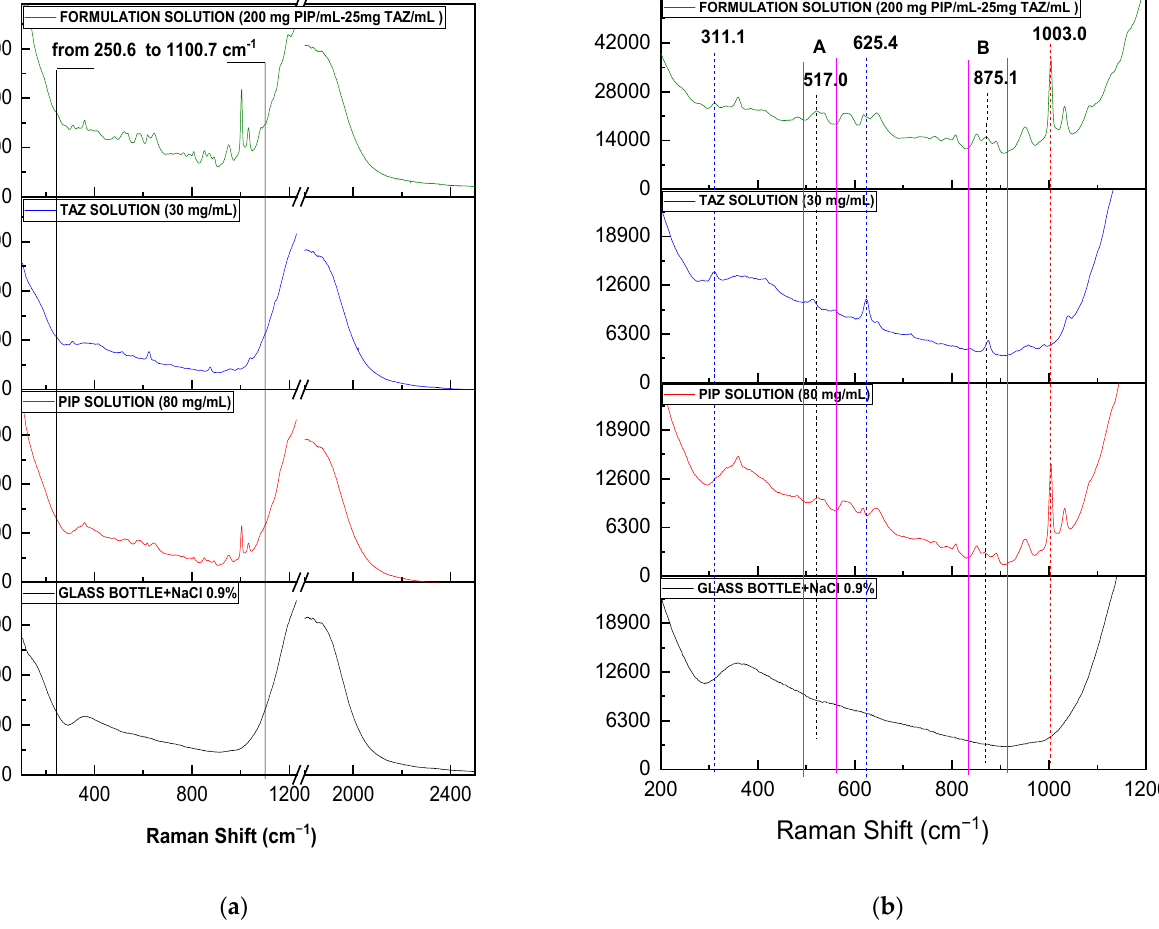
Figure 5. ( a ) Raman solution spectra of PIP (80 mg/mL), TAZ (30 mg/mL), and the formulation (200.00 mg PIP/mL and 25.00 mg TAZ/mL), obtained through the glass container of the formulation, as well as that of the glass bottle filled with NaCl 0.9% (blank sample): ( a ) from 100 to 2500 cm − 1 and ( b ) from 200 to 1200 cm − 1 . The framed spectral region from 250 to 1100 cm − 1 (black frame on the left) corresponds to the wavenumber range where the sample peaks appear. Differences between PIP and formulation spectra due to TAZ presence are with blue dotted lines and in the spectral regions A (493–562 cm − 1 ) and B (834–913 cm − 1 ). The characteristic peak of PIP at 1003 cm − 1 is with the red dotted line.